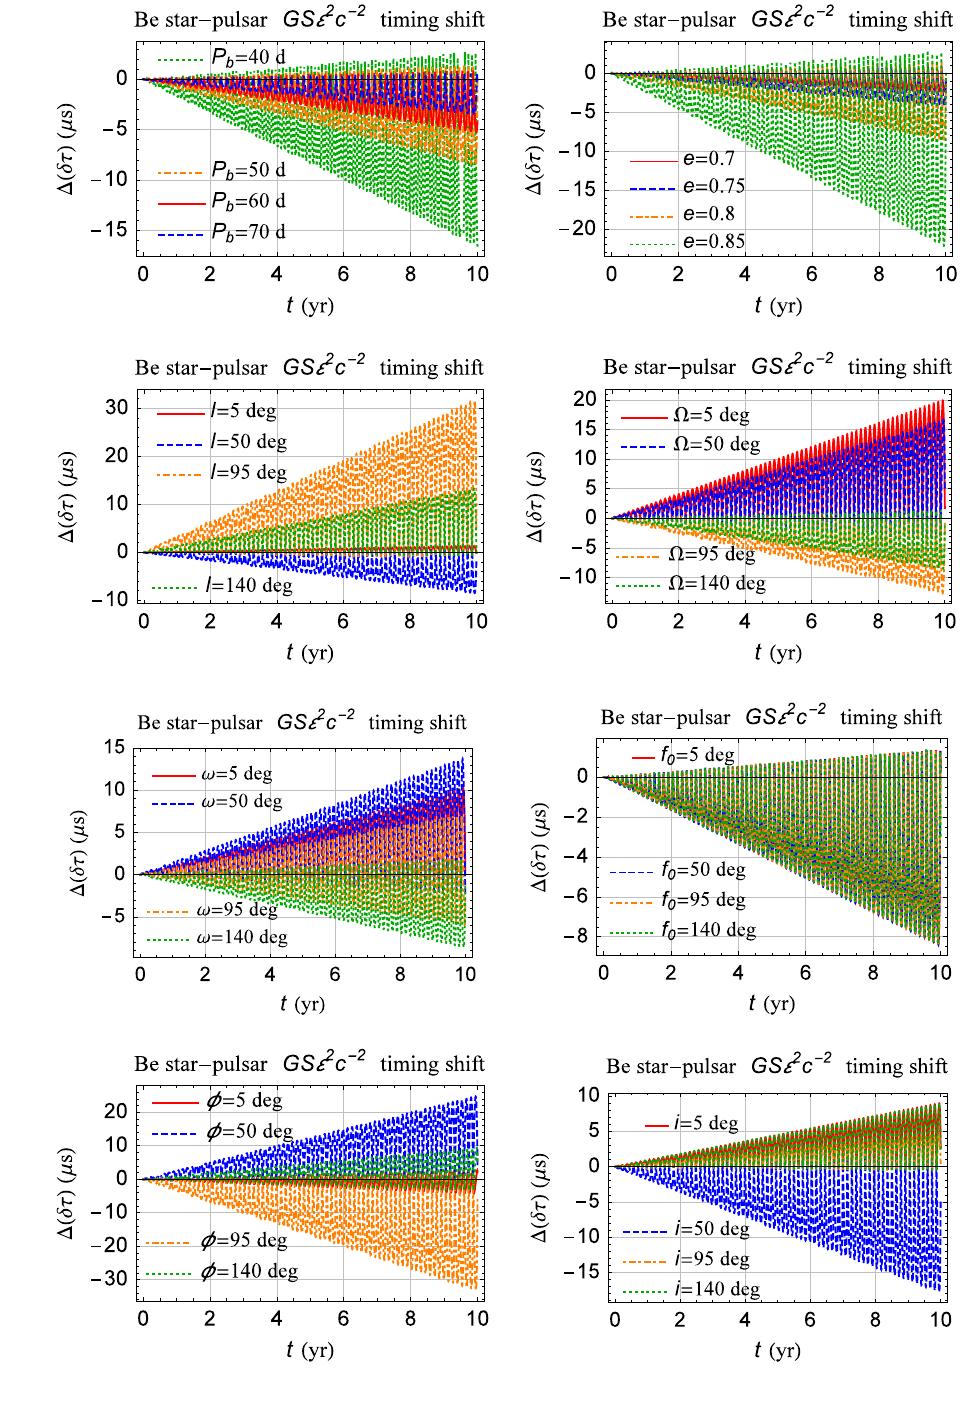
Fig. 5 Numerically integrated time series of the timing shift (cid:4)(δ τ ) due to Eq. (9), in μ s, for variations of the parameter space of a fictitious binary pulsar, characterized by P b = 50 days , e = 0 . 8 , I = 50 deg , (cid:12) = 140 deg , ω = 149 deg , f 0 = 228 deg,